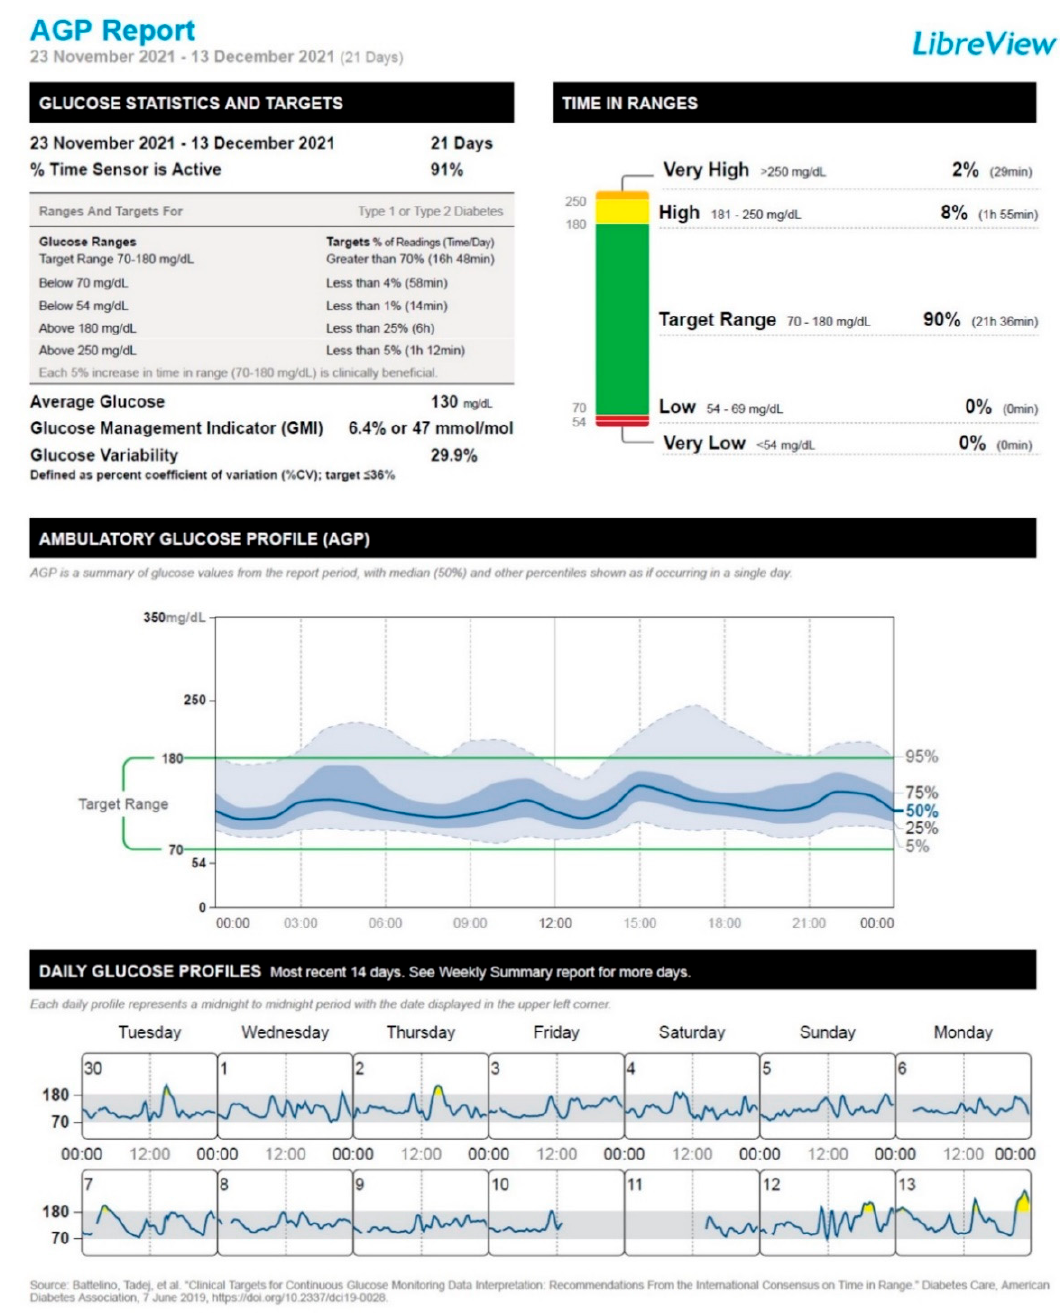
Figure 1. Ambulatory glucose profile (AGP) obtained from the subcutaneous glucose sensor referring to the 21 days before the first vaccine dose injection (23 November 2021 through 13 December 2021).